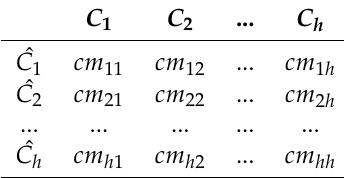
Table 4. Mathematical example of confusion